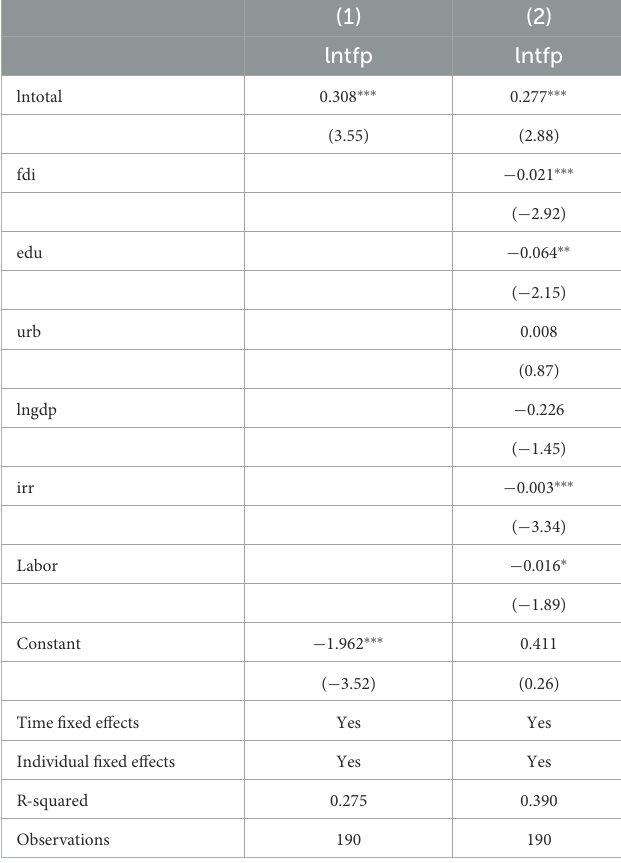
TABLE 4 Estimation results of the impact of agricultural trade on TFP.